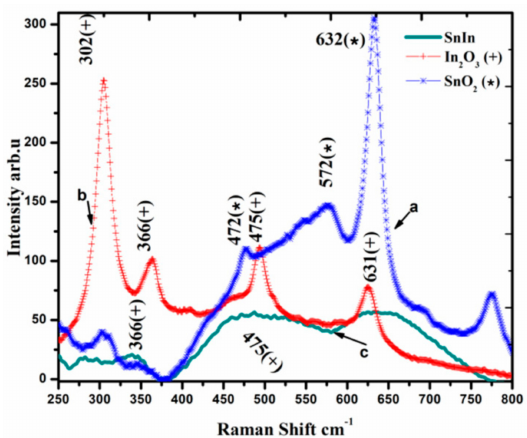
Figure 3. Raman spectra of SnO 2 , In 2 O 3 and SnO 2 -In 2 O 3 (85:15 wt%) nano-powders.